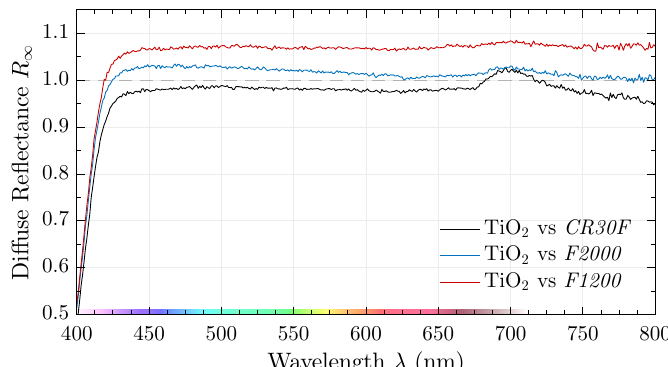
Figure 8. Diffuse reflectance of a nominally pure TiO 2 against different aluminum oxides: CR30F , F2000 and F1200